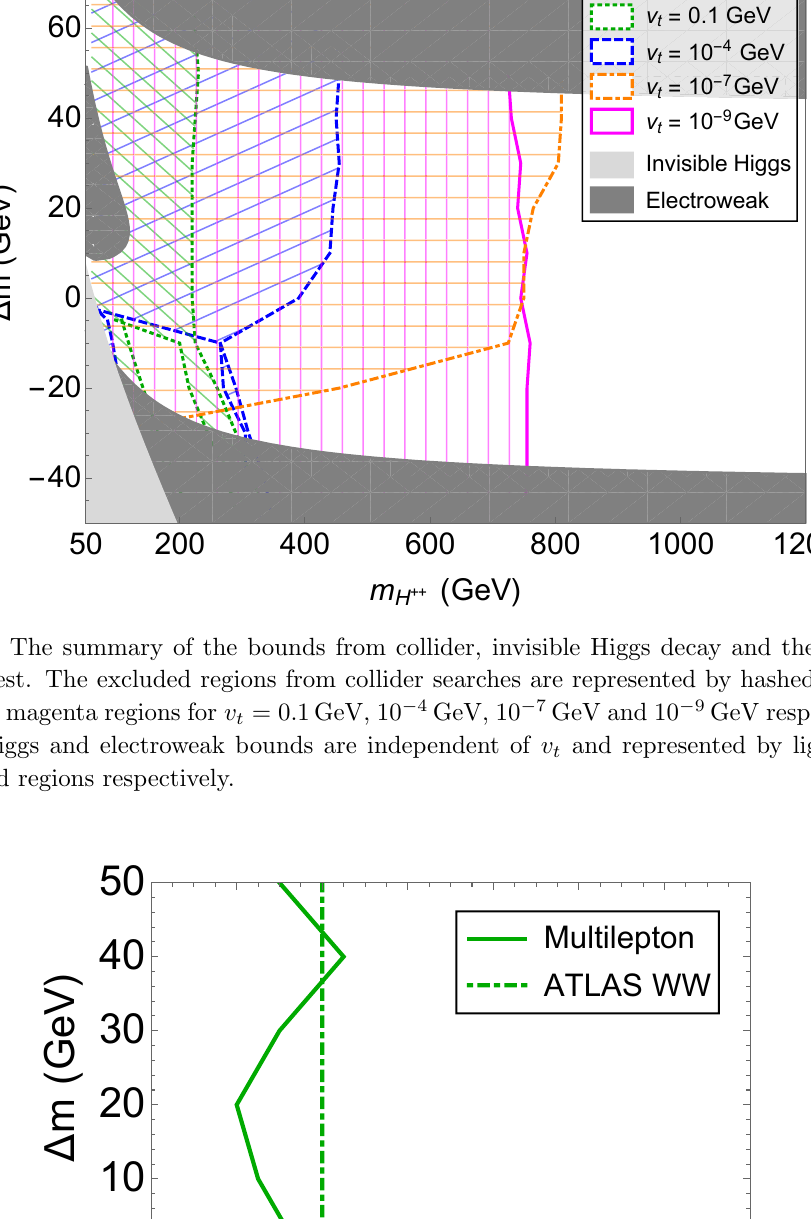
= 0 . 1 GeV. The region on the left of the t